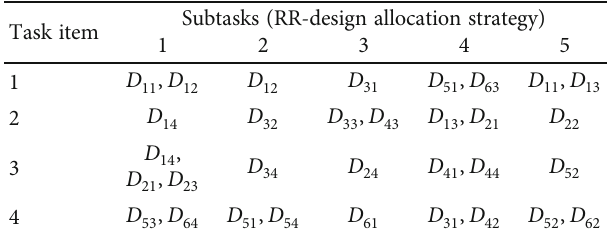
Table 18: RR-design allocation strategy. Task item